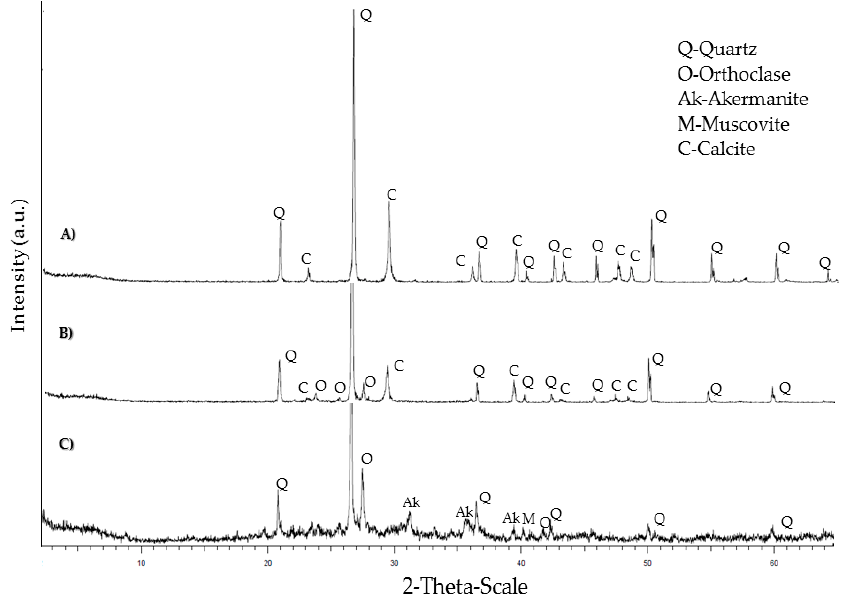
Figure 2. XRD mineral analysis of sands ( A ), concrete ( B ) and ceramics ( C ).